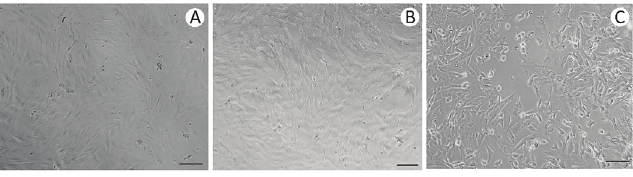
Figure 1 - Cultured fibroblast monolayers treated with various concentrations of the food additive E407a (A - 0 µg/ml; B - 100 µg/ml; C - 5 mg/ml) during 24 h. Phase contrast microscopy. The scale bar is 100